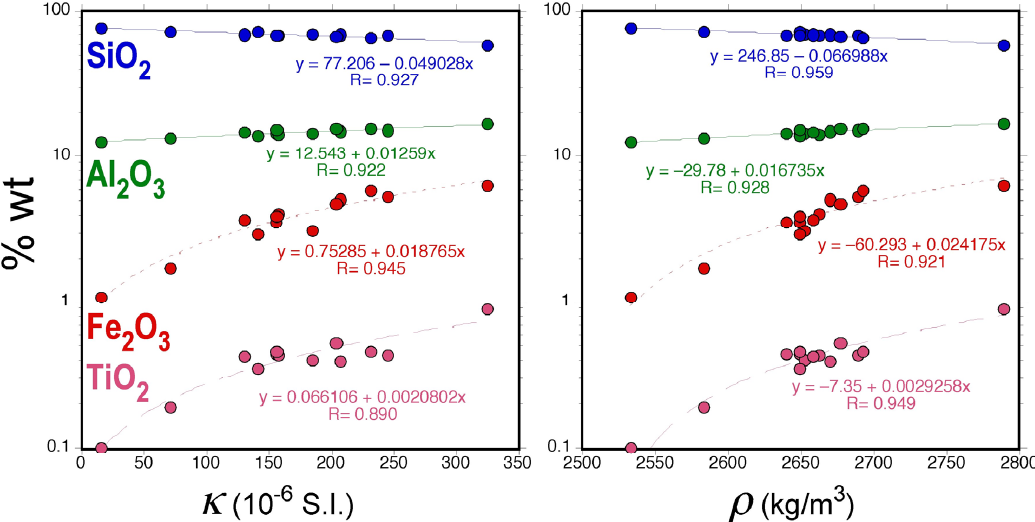
Figure 12. Geochemical data (% in wt of SiO 2 , Al 2 O 3 , Fe 2 O 3 and Ti0 2 ) against rock density ( ρ ) and magnetic susceptibility ( κ ) as well as the linear regressions stablished among them in some type-2 samples frm Maladeta and Mont Louis Andorra